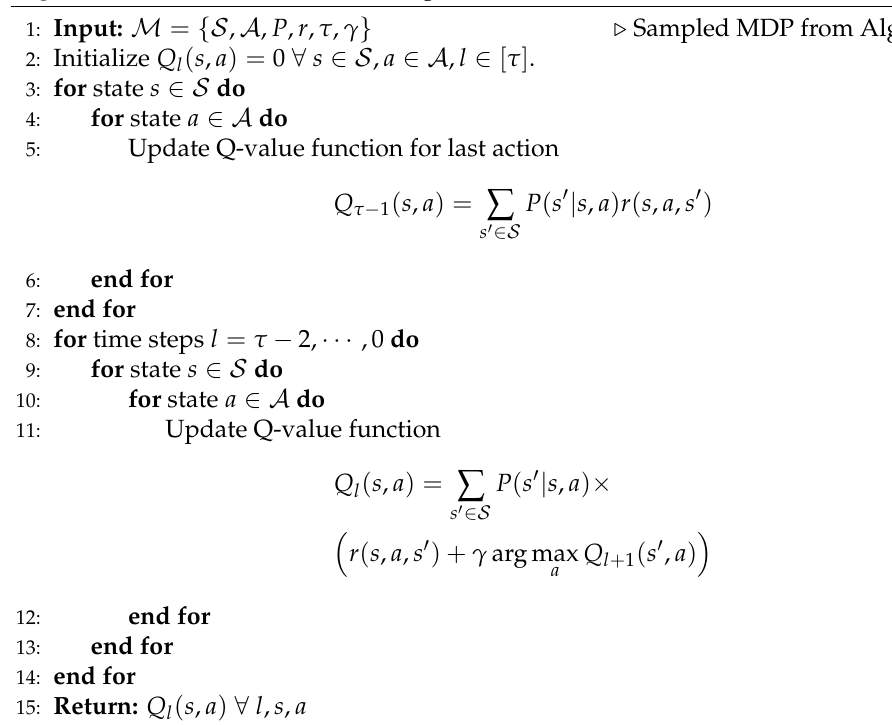
Algorithm 2 Backwards Induction